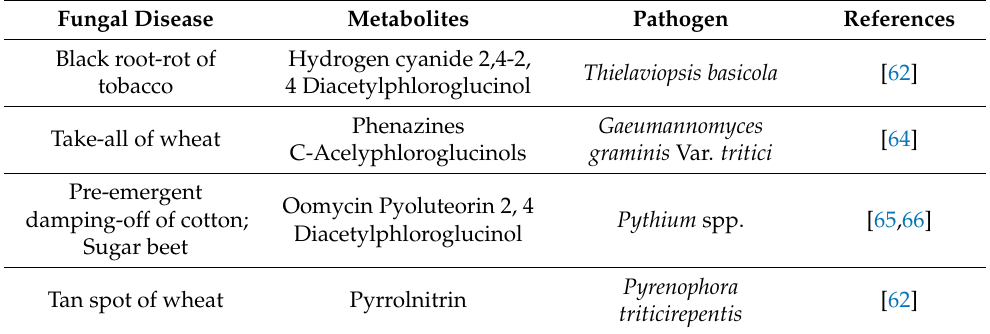
Table 6. Metabolites secreted by Pseudomonas acting against fungal pathogens of plants. Fungal